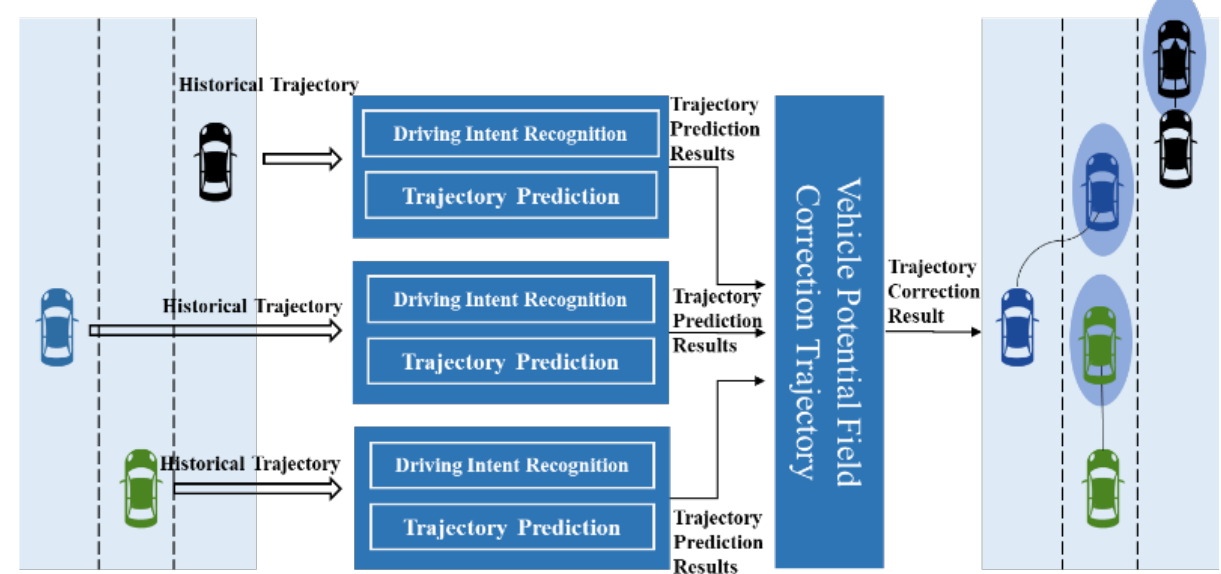
Figure 1. The architecture of the vehicle motion prediction algorithm.